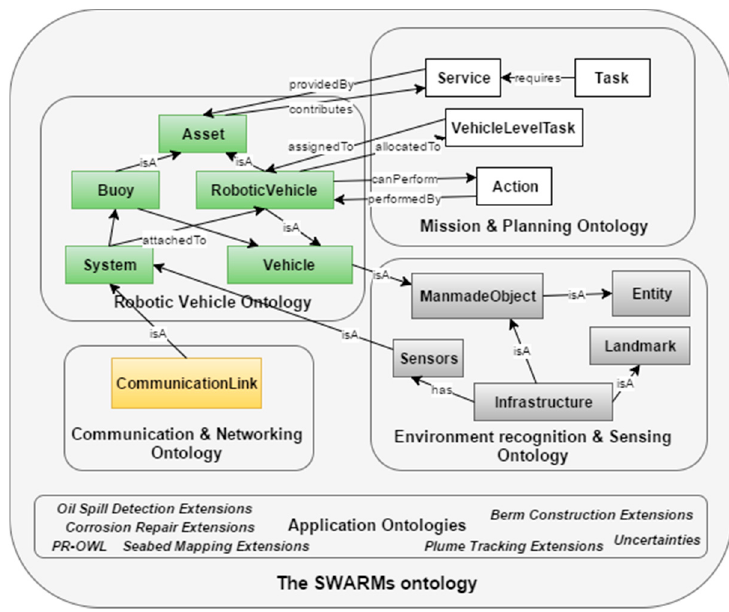
Figure 3. The structure of the Smart and Networking Underwater Robots in Cooperation Meshes (SWARMs) ontology.